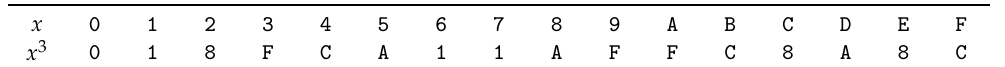
Table 2. x 3 over F 2 4 .